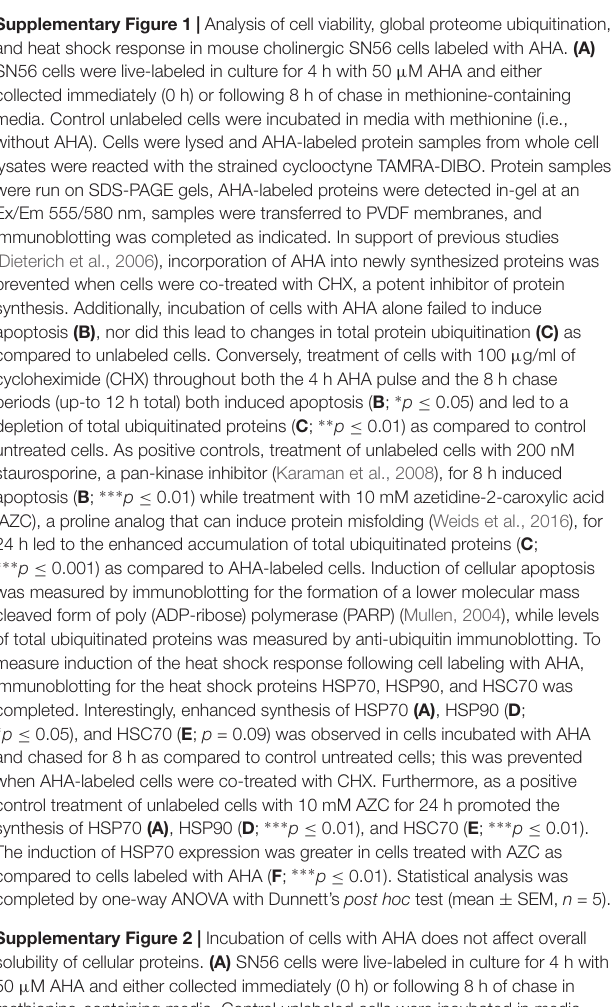
both fractions) and led to the enhanced accumulation of total ubiquitinated proteins in both the Triton-soluble ( B ; ∗∗∗ p ≤ 0.001) and Triton–insoluble fraction ( C ; ∗∗∗ p ≤ 0.001) as compared to AHA-treated cells. Statistical analysis was completed by one-way ANOVA with Tukey’s post hoc test (mean ± SEM, n = 3). Supplementary Figure 3 | Analysis of cell viability, global proteome ubiquitination, and heat shock response in human HEK293 and HeLa cells labeled with AHA. (A) HEK293 or HeLa cells were live-labeled in culture for 4 h with 50 µ M AHA and either collected immediately (0 h) or following 8 h of chase in methionine-containing media. Control unlabeled cells were incubated in media with methionine (i.e., without AHA). As a positive control, unlabeled cells were treated with either 10 mM AZC for 24 h to induce protein misfolding. Cells were lysed and AHA-labeled protein samples from whole cell lysates were reacted with the strained cyclooctyne TAMRA-DIBO. Protein samples were run on SDS-PAGE gels, AHA-labeled proteins were detected in-gel at an Ex/Em 555/580 nm, samples were transferred to PVDF membranes, and immunoblotting was completed as indicated. Similar to SN56 cells ( Supplementary Figure 1 ), incubation with AHA failed to induce apoptosis ( B – HEK293; C – HeLa) or lead to changes in total protein ubiquitination in either HEK293 (D) or HeLa cells (E) as compared to unlabeled cells. Conversely, treatment of cells with AZC induced apoptosis ( B – HEK293; C – HeLa; ∗∗∗ p ≤ 0.001) and enhanced the accumulation of total ubiquitinated proteins in either HEK293 ( D ; ∗∗∗ p ≤ 0.001) or HeLa cells ( E ; ∗∗∗ p ≤ 0.001) as compared to AHA-labeled cells. Induction of cellular apoptosis